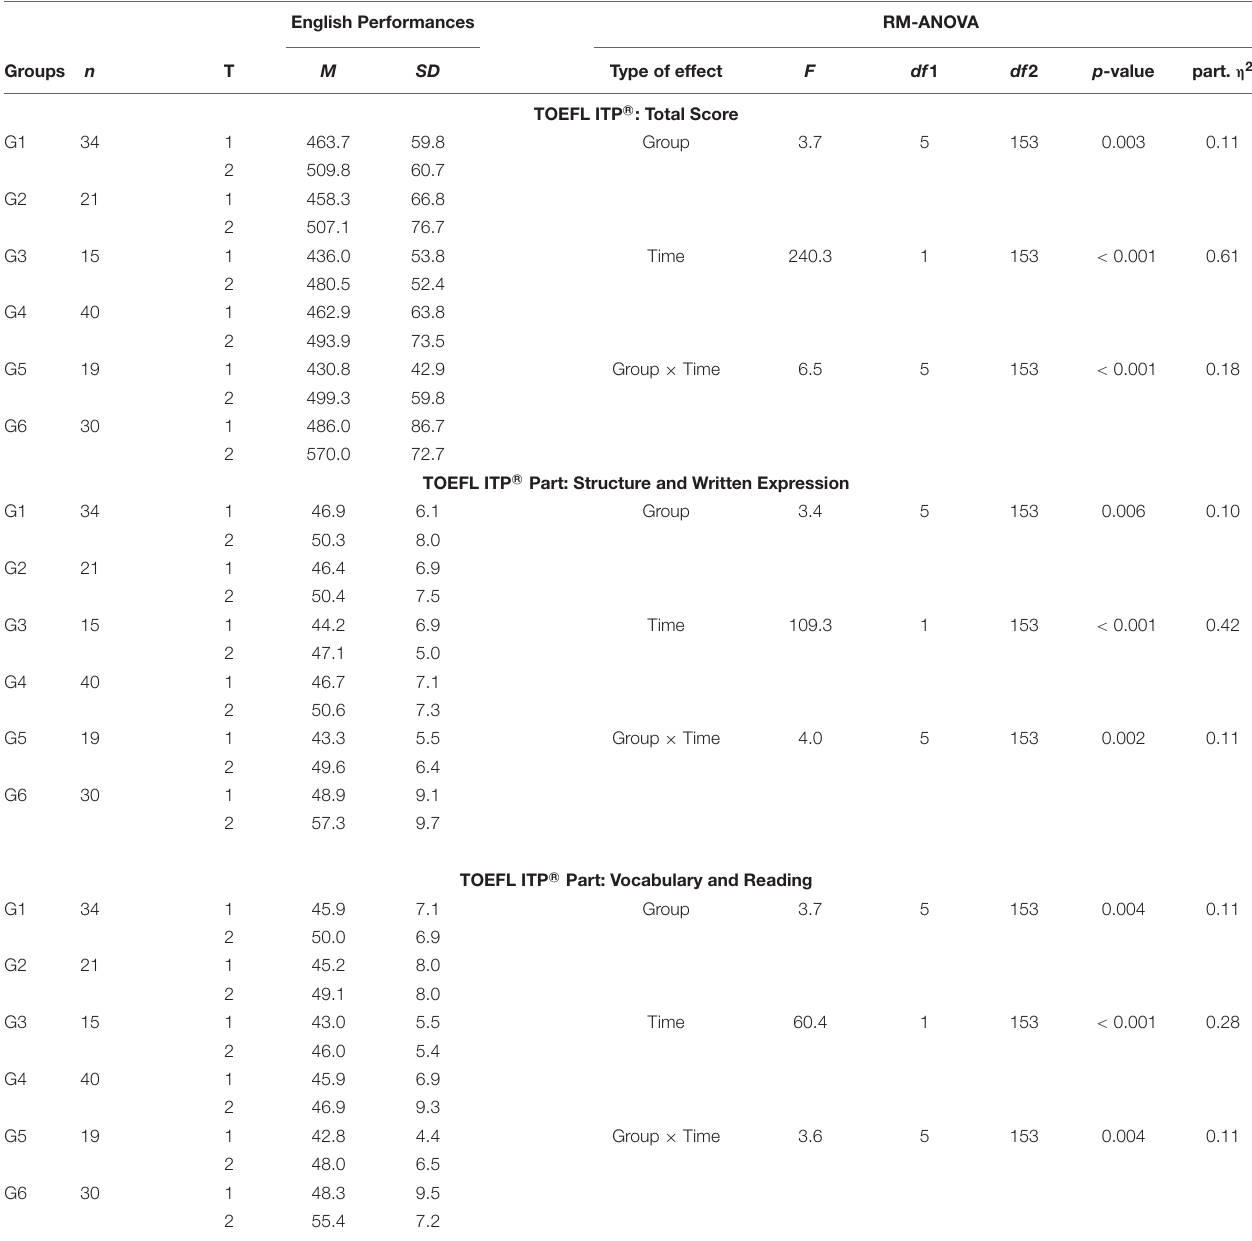
TABLE 4 | Comparison of English test performances using groups 1–6. English